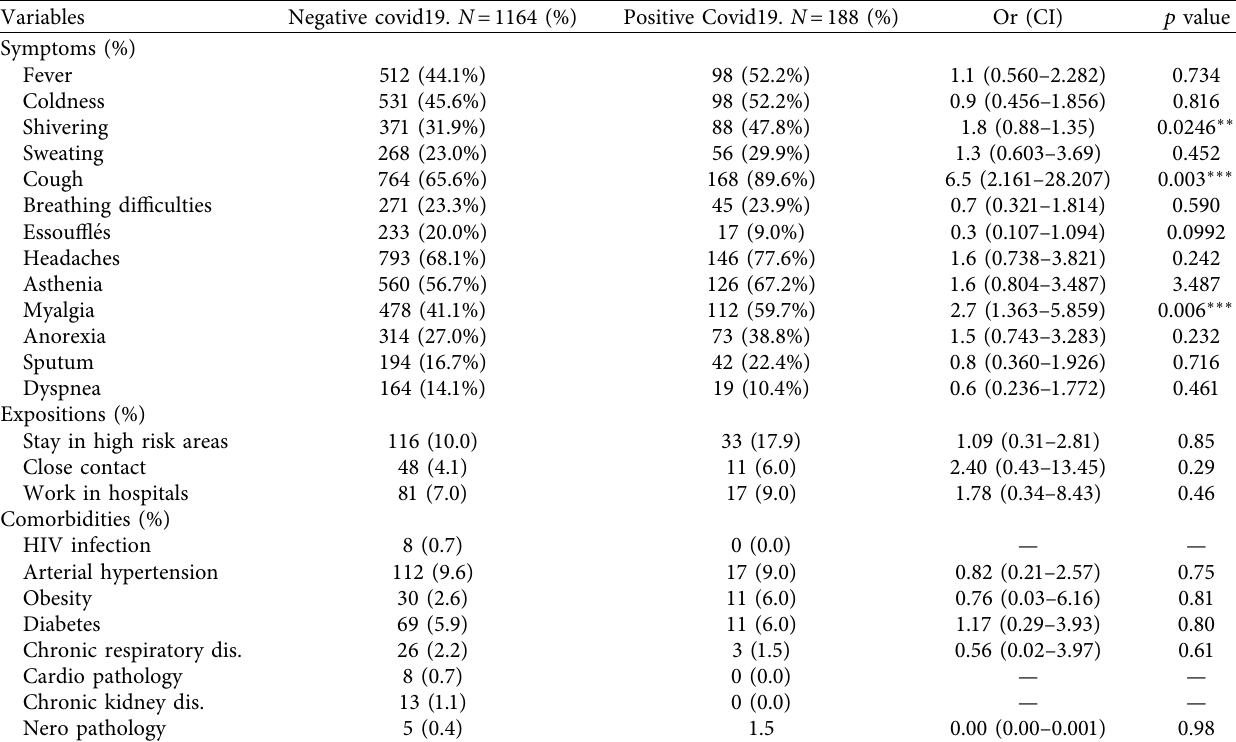
Table 2: Association of flu-like symptoms with SARS-CoV-2 positivity among flu-like patients seeking treatment in different health facilities.